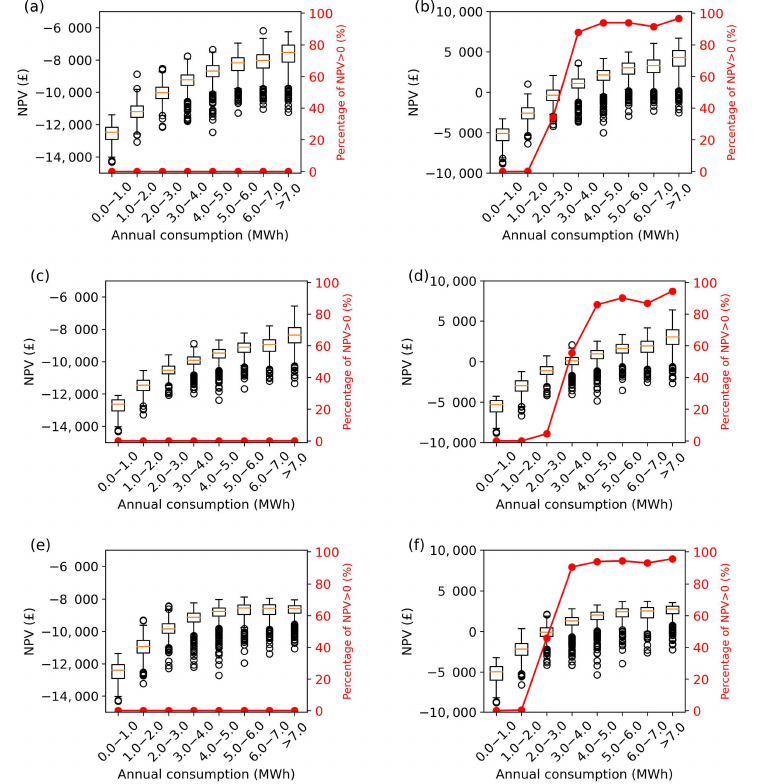
Figure 8. NPV distributions segregated into different annual consumption brackets for the fixed PV + BES system. ( a ) Agile tariff in the baseline costs scenario. ( b ) Agile tariff in the future costs scenario. ( c ) Std tariff in the baseline costs scenario. ( d ) Std tariff in the future costs scenario. ( e ) ToU tariff in the baseline costs scenario. ( f ) ToU tariff in the future costs scenario. The red line illustrates the percentage of consumers within the consumption bracket with NPV > 0.